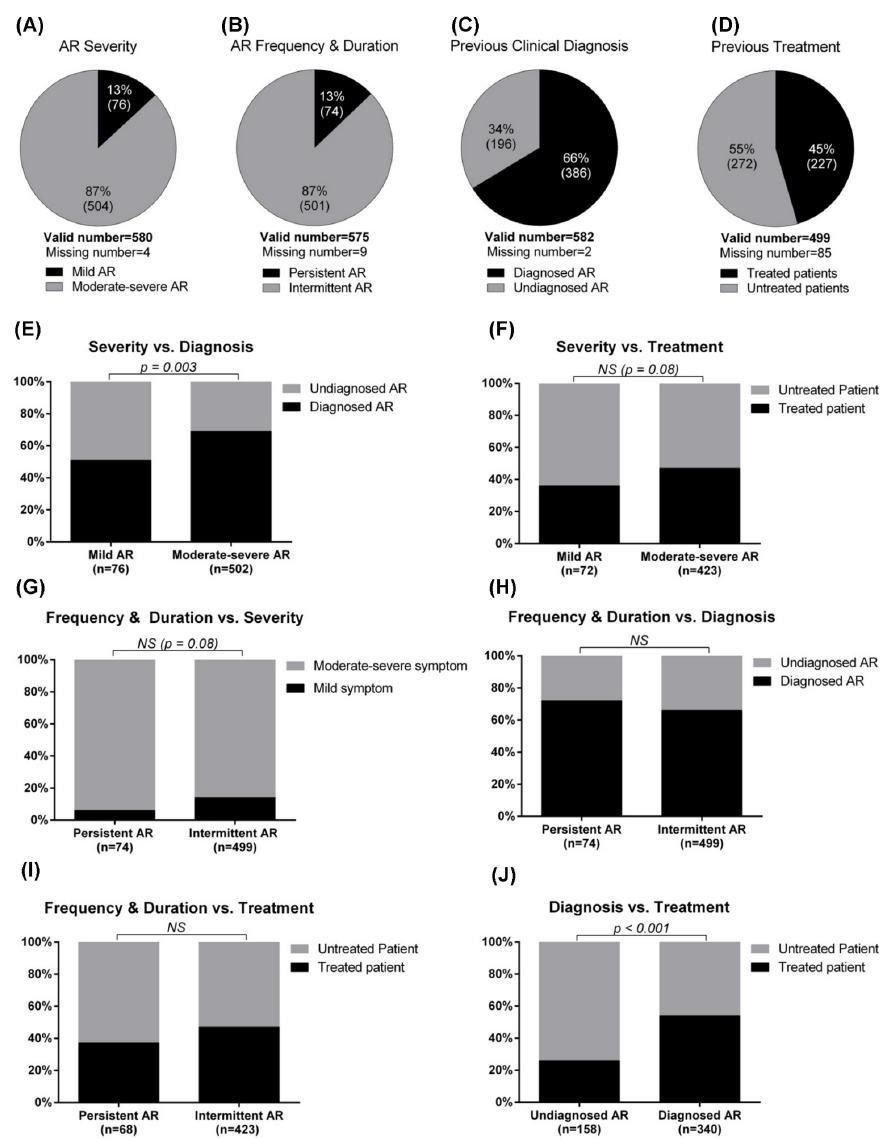
Fig. 3. Clinical information of AR. Classification of AR based on the symptom severity (A) and frequency & duration (B); conditions of previous clinical diagnosis (C) and previous medical treatment (D). Relationships between AR classification and diagnosis/treatment status were analyzed by chi-square test: symptom severity and diagnosis (E), symptom severity and treatment (F), symptom severity and symptom frequency/duration (G), symptom frequency/duration and diagnosis (H), symptom frequency/duration and treatment (I), and diagnosis and treatment (J). A p -value below 0.05 was considered statistically